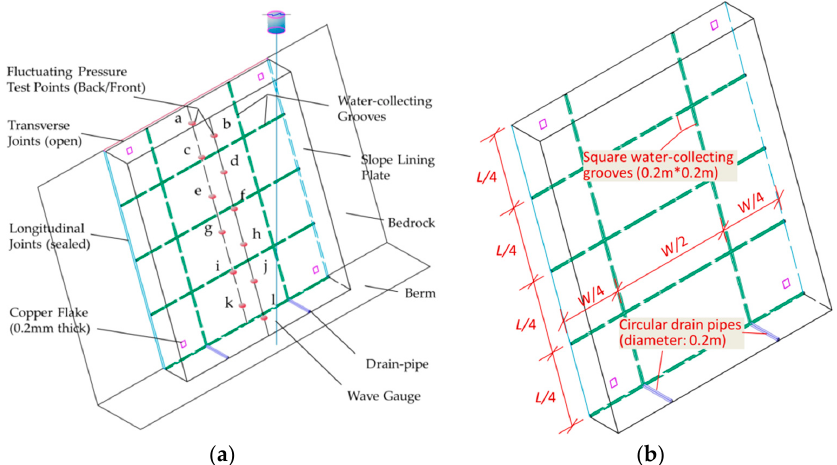
Figure 15. Structural design for the improved slope lining plate. ( a ) plate design; and ( b ) detailed physical dimension.